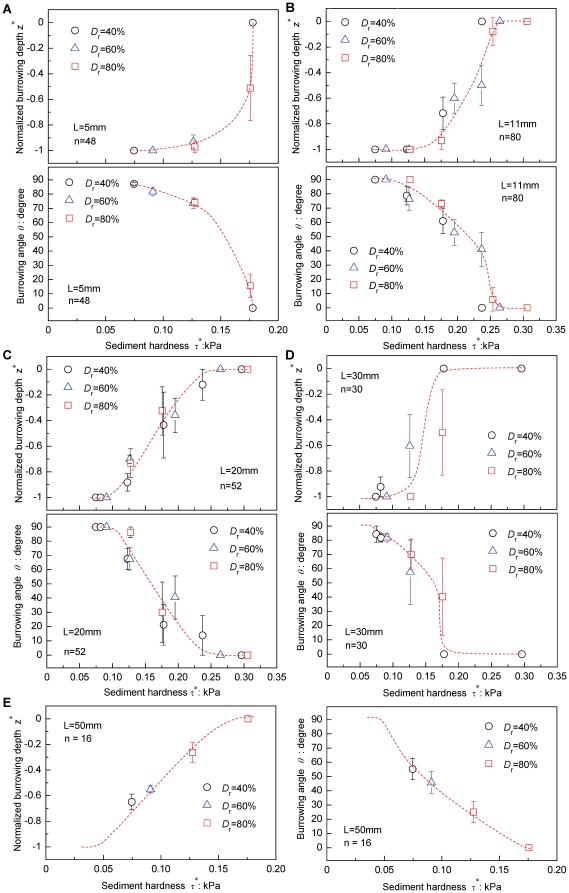
Burrowing criteria and burrowing mode adjustment in Ruditapes philippinarum.Measured normalized burrowing depth z* and burrowing angle θ versus sediment hardness for five stages of growth: (A) L = 5 mm, (B) L = 11 mm, (C) L = 20 mm, (D) L = 30 mm, and (E) L = 50 mm. The sediment hardnesses τ* were varied by changing suctions s and sediment relative densities D
r at 40%, 60%, 80%, as shown in Table 1 and Figure 1D. Data represent mean values ± SE. The results of the related statistical analyses (GLM) are shown in Table 3A,B.